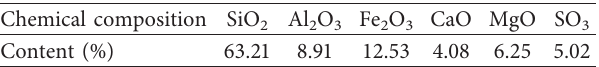
Table 2: Main chemical components of